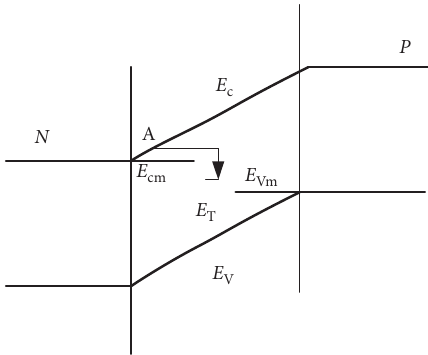
Figure 5: Energy band diagram of a depletion layer around a forward-biased junction. The constants E cm and E vm denote the boundary levels, from which the tunneling is